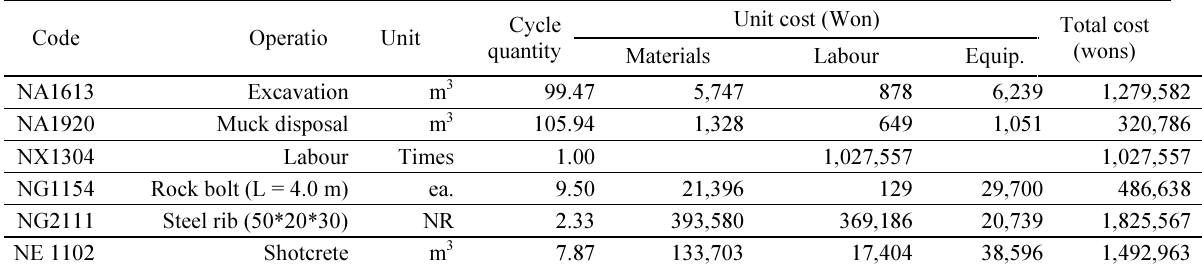
Table 3. One-cycle unit cost of Type-IV-Top